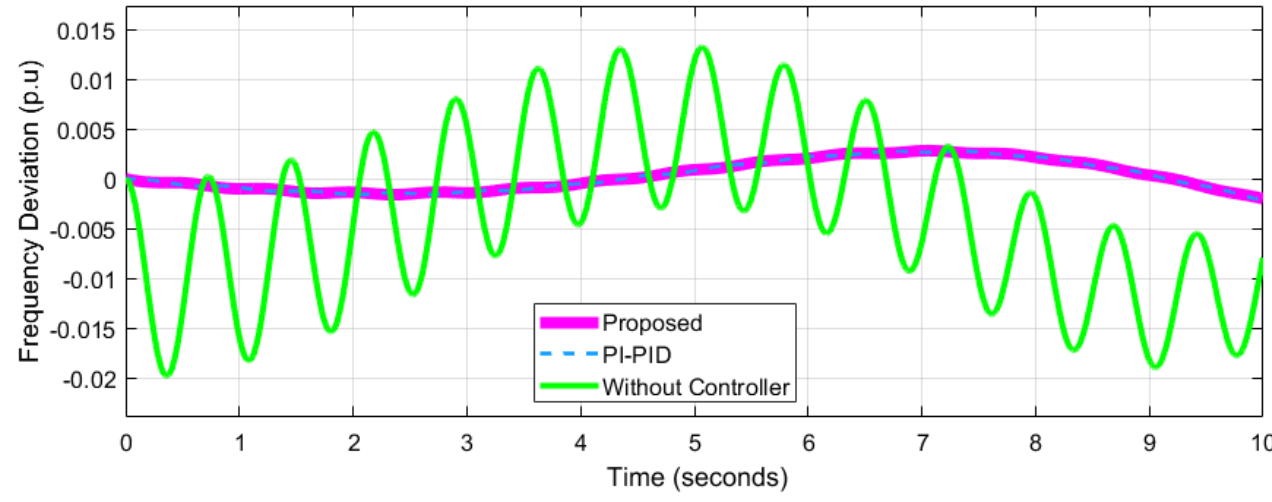
Figure 12. Case 2: frequency deviation at (K p = −1.8700, K i = −0.0040) for network 3.